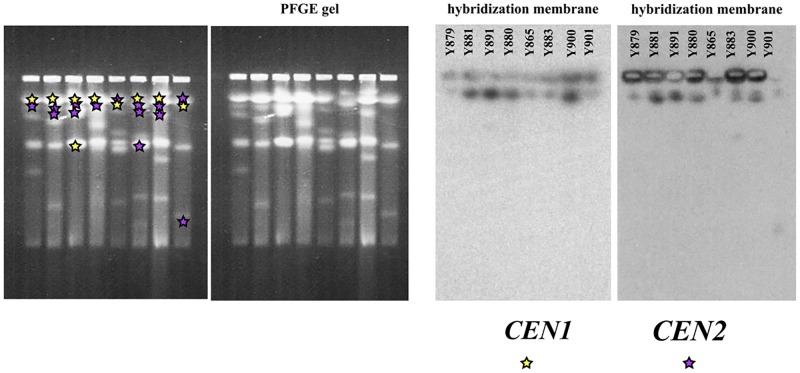
Hybridization of CEN1 and CEN2 to chromosomes.The chromosome-sized DNA of the strains (Y879, Y881, Y891, Y880, Y865, Y883, Y900, and Y901) was separated on PFGE gel and hybridized with CEN probes. For the CEN1 locus, the full fragment was used as a probe (amplified with primers OP98 and OP99). For the CEN2 locus, the CEN2-1 part (amplified with primers OP91 and OP127) was used as a probe; this was performed to avoid the transposon part, which is present in the genome in several copies. The hybridization signals for both CEN1 and CEN2 were marked with yellow and purple stars on the PFGE gel.